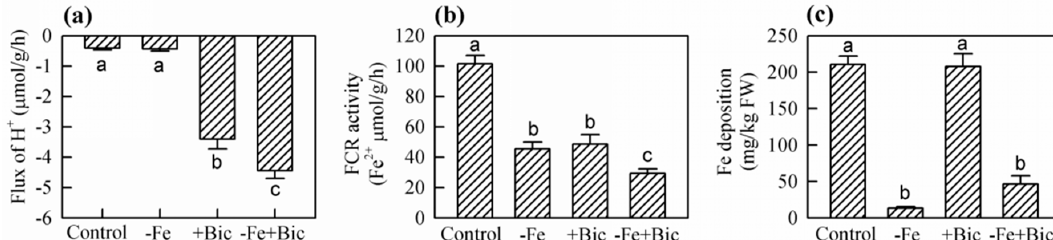
Figure 3. The proton (H + ) extrusion ( a ), ferric chelate reductase (FCR) activity ( b ) in roots and Fe deposition on root surface ( c ) of kiwifruit plants treated with -Fe, +Bic or -Fe+Bic in solution culture for 35 days. Values are means of five replicates ± SE. Different letters indicate significant differences among the treatments at P < 0.05. FW, fresh weight.